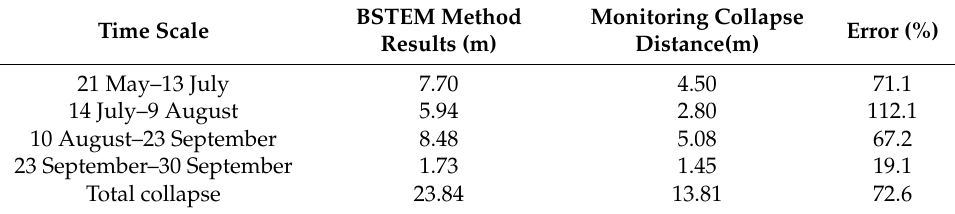
Table 12. BSTEM results, field measurements and errors for surveying Section